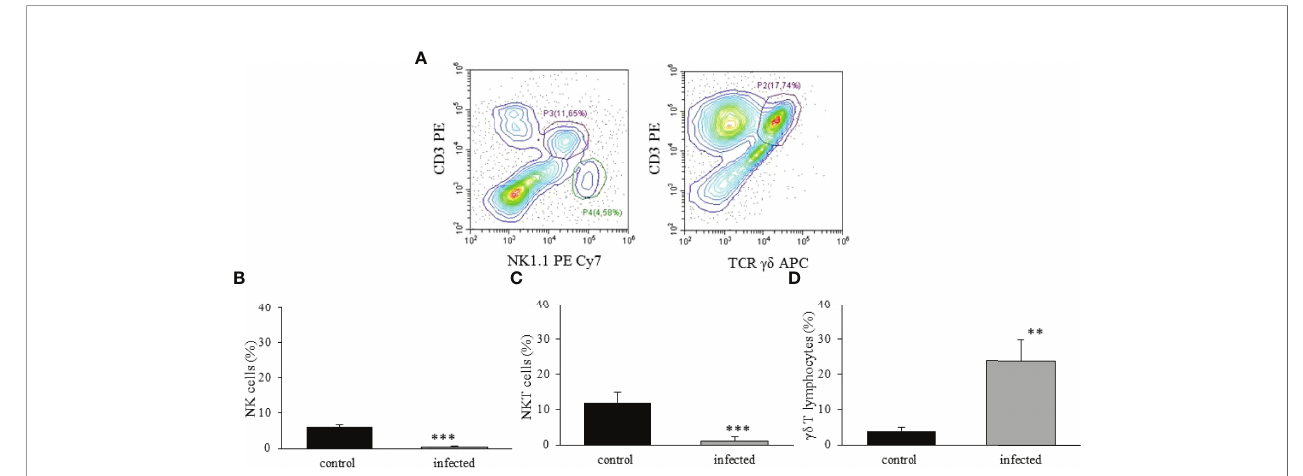
FIGURE 7 | Analysis of NK, NKT, and gd T lymphocytes in the liver of T. cruzi infected mice. C57BL/6 mice were IP infected with T. cruzi , and the hepatic cells were isolated by enzymatic dissociation on dpi 15. The identi fi cation of NK (NK1.1 + CD3 - ), NKT (NK1.1 + CD3 + ), and gd T lymphocytes (CD3 + gd TCR + ) are shown in (A) For better visualization of the populations, a dot plot from a control mouse illustrates the analysis gate of NK and NKT cells, and a dot plot from an infected animal shows the gate of gd T lymphocytes. The frequency of each cell population is indicated (B – D) in control and infected mice. ** means p ≤ 0.05 and *** means p ≤ 0.01. For NK and gd T lymphocytes, we used the one-way ANOVA test followed by the Tukey ’ s post-test, and for NKT cells we used the Kruskal Wallis followed by the Dunn ’ s